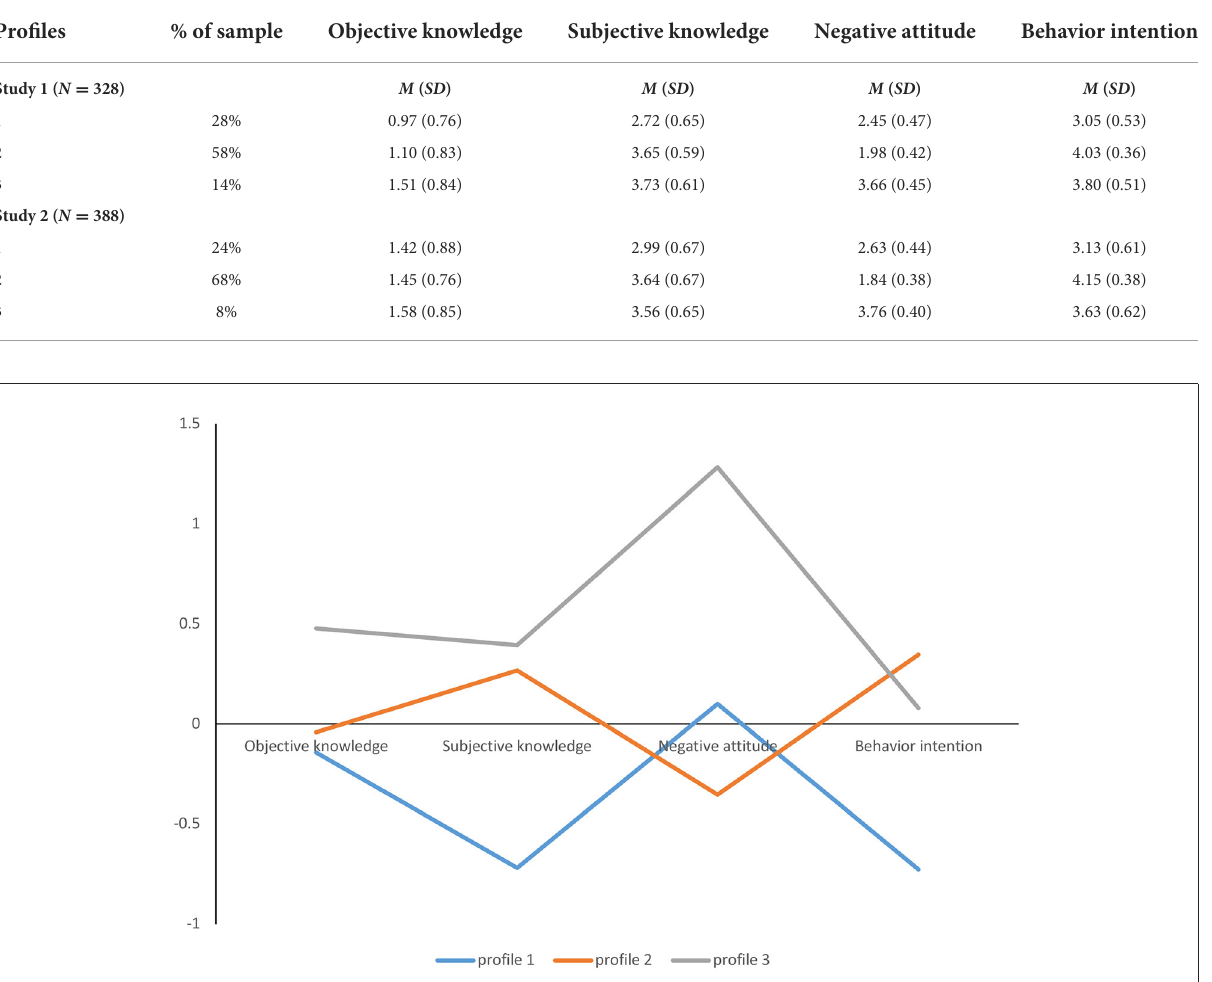
FIGURE2 Latent profiles KAB profiles of medical AI. The y-axis refers to the mean Z score of the participants’ objective knowledge, subjective knowledge, negative attitude, and behavioral